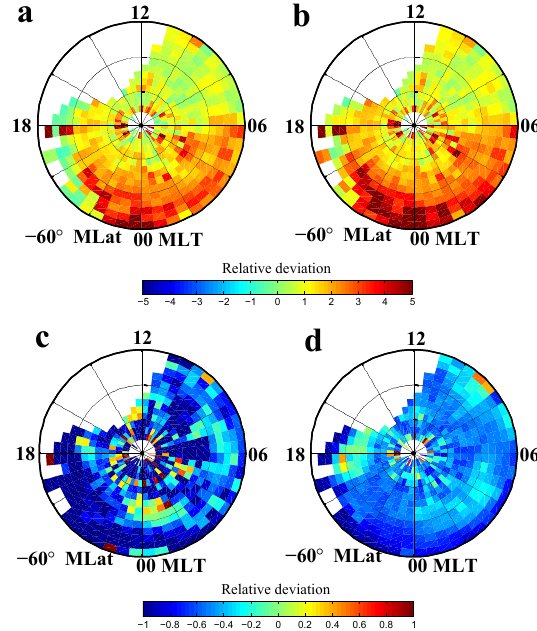
Figure 5. Scatter points of normalized upflow parameter versus year: (a) P index, (b) normalized ion upflow density (red circle) and its flux (black circle), and (c) normalized ion upward drift (red circle) and upflow occurrence frequency (black circle). The curves show the corresponding polynomial fitting